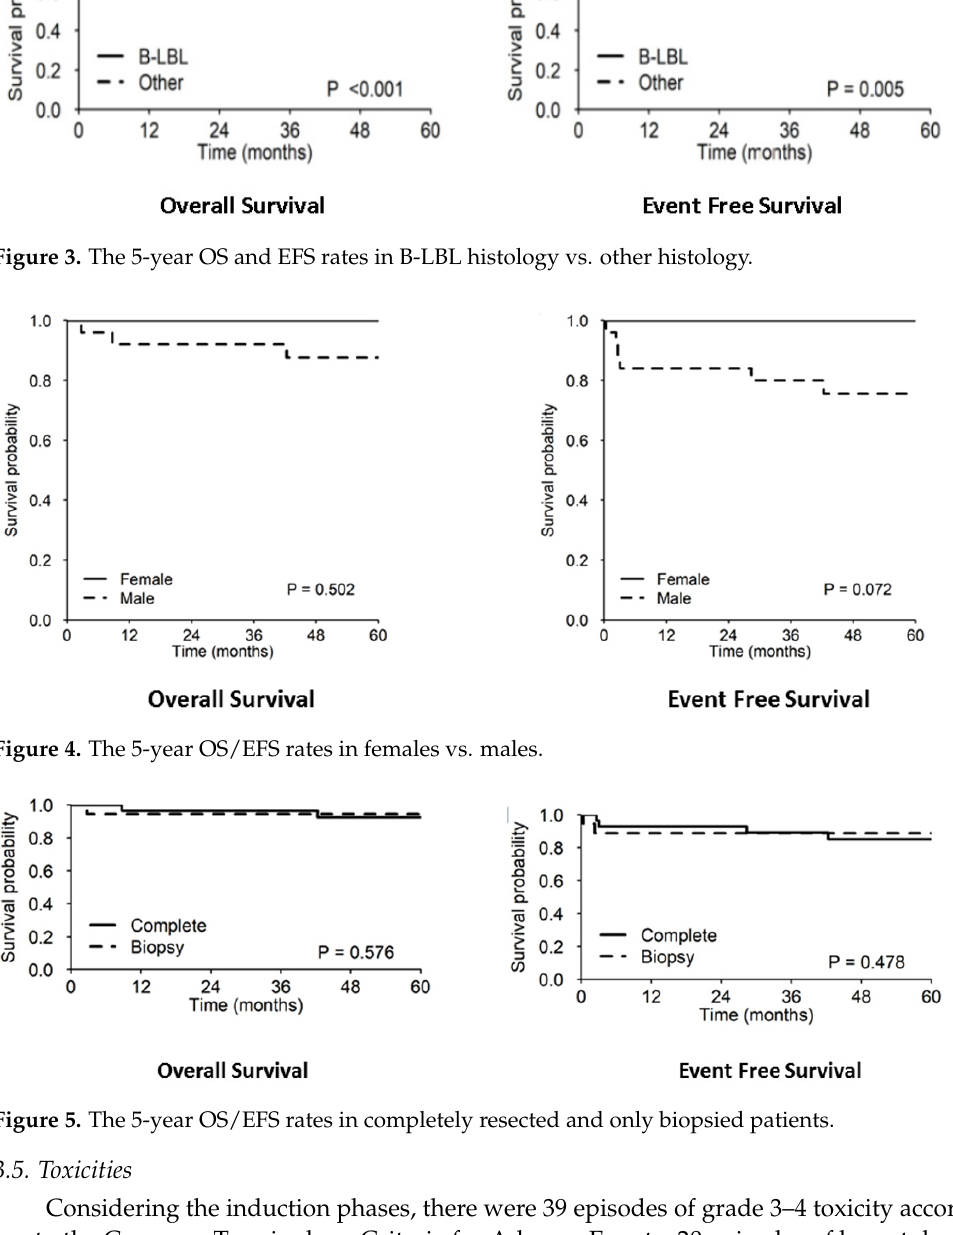
Figure 5. The 5-year OS/EFS rates in completely resected and only biopsied